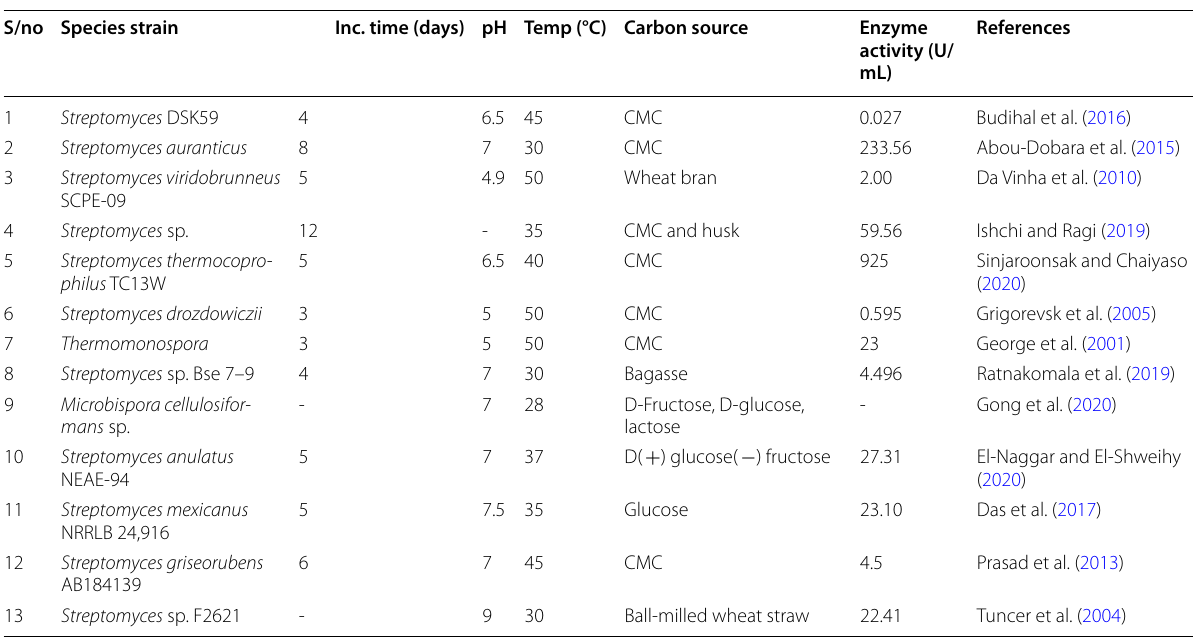
Table 3 Some cellulase-producing actinomycetes species